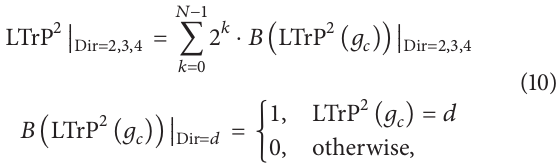
𝐼 1 (𝑔 ) = 𝐼 1 (𝑔 ) , which is defined in equation (9). 𝑐 𝑘 Dir Dir